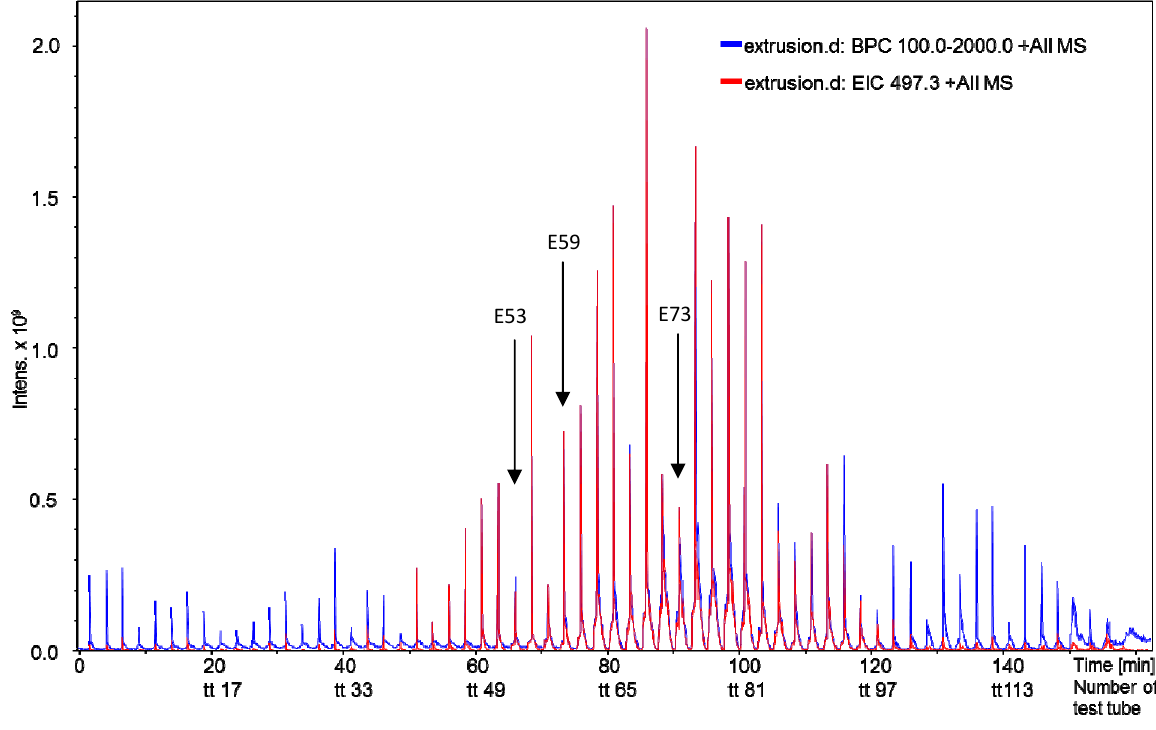
Figure 1. Mass spectrometric (direct injection ion trap +ESI MSMS) monitoring of spCCC fractions obtained in extrusion mode. Every second test tube (axis lable TT) was analyzed. Red: extracted target ion trace of m/z = 497, Blue: base peak chromatogram of m/z 100–2000. Arrows: Subfractions E53 and E73 as well as E59 shown in Figure 2. Compound 1 was isolated from the pooled subfractions